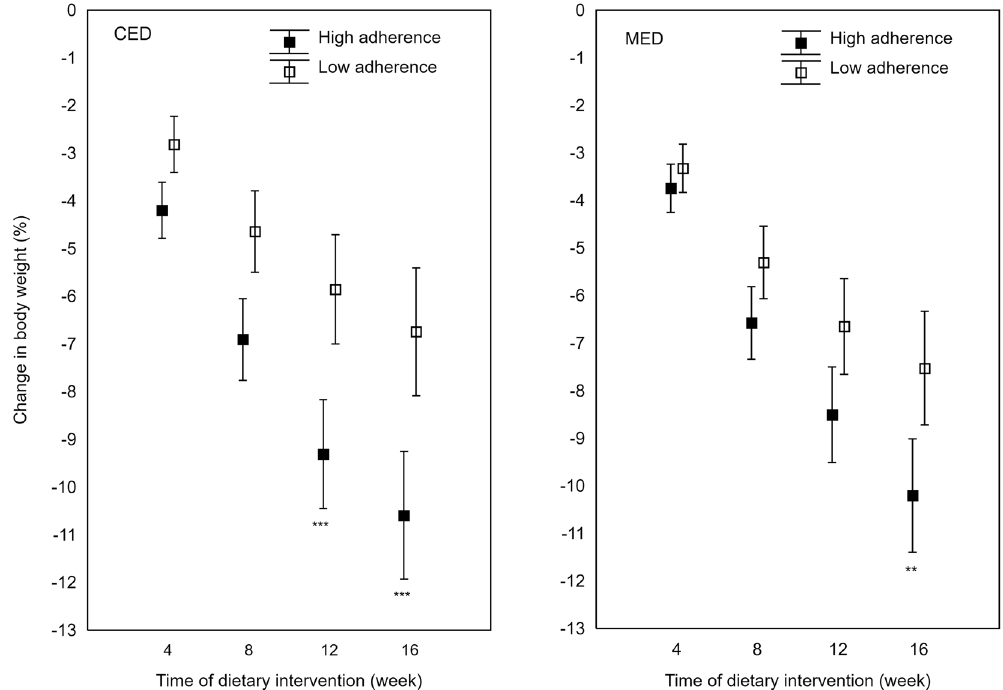
Figure 2. Mean percent body weight changes over 16 weeks of dietary intervention in the more adherent (filled square) and less adherent (open square) postmenopausal women from the CED (left side) and the MED (right side) groups, respectively. Data are presented as means (CI 95%), ** P < 0.01, *** P < 0.001 for differences between level of adherence at respective time